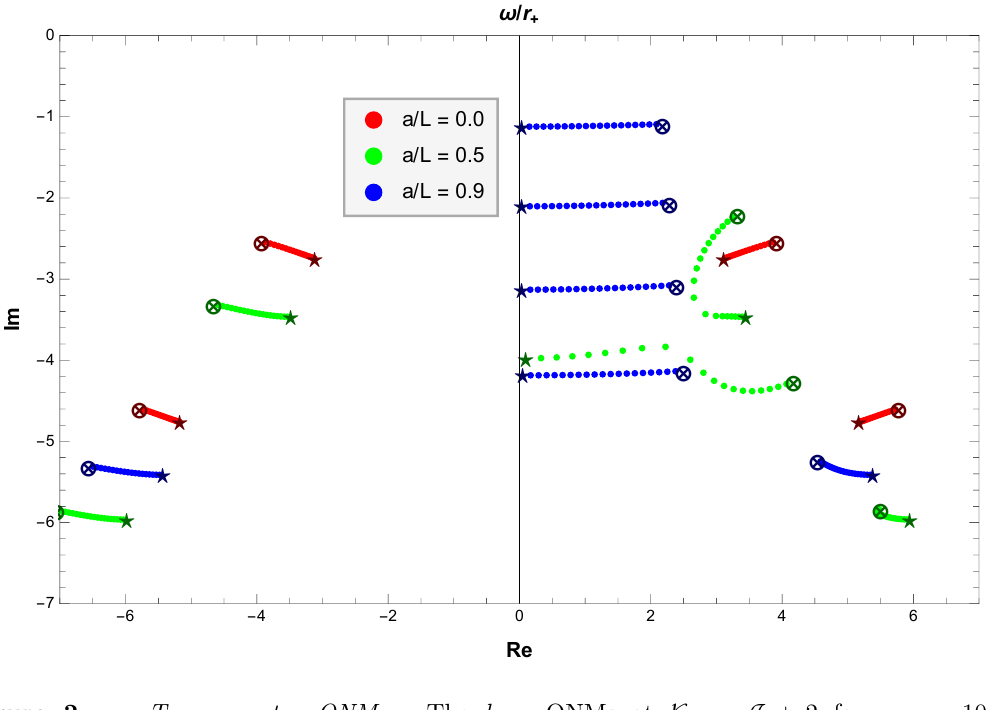
Figure 2 . Tensor sector QNMs. The h ++ QNMs at K = J + 2 for r + = 100 at J = 0 ; 5 ; 10 ; 20 ; : : : ; 100, where the star indicates the value at J = 0, the circled cross indicates J = 100. This is case